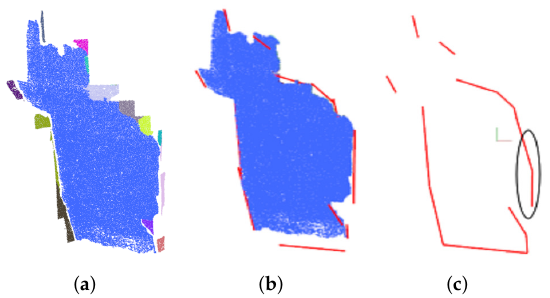
Figure 4. Basic model generation. ( a ) The connectivity information of a plane and related edge information. ( b ) Boundary reconstruction. ( c ) Corner calculation. The black circle area in the figure is closed by adding triangular